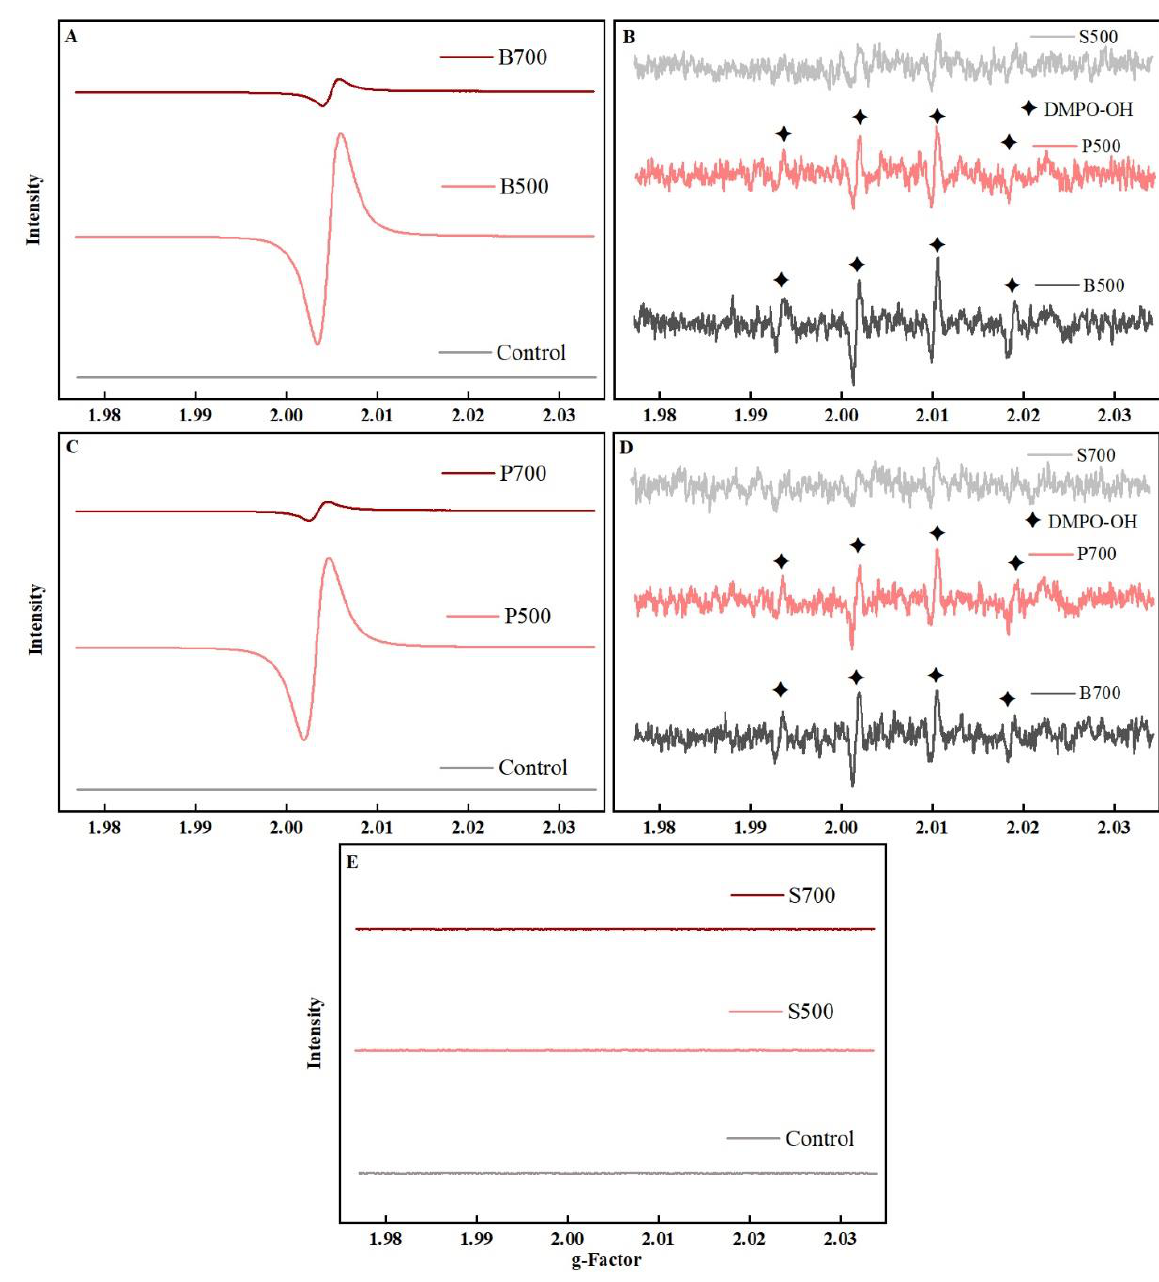
Figure 3. The EPR spectra of biochar at 500 and 700 °C. The resulting intensity of unwashed biochar ( A ), washed particle ( C ), and supernatant ( E ) was divided by their mass (mg −1 ). EPR signals of DMPO-OH ( B , D ) are marked as four-point stars ( ✦ ).